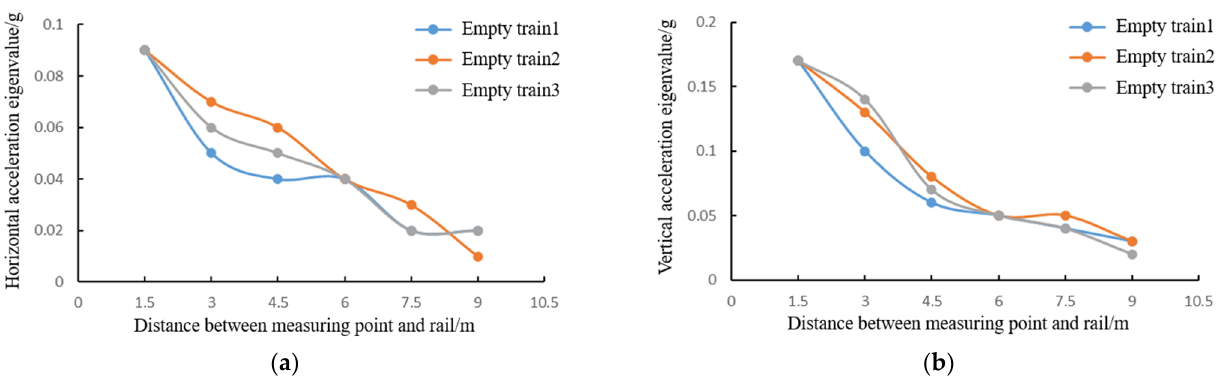
Figure 10. Acceleration change curve of each measuring point of the no-load train. ( a ) Horizontal acceleration change curve of each measuring point of the no-load train; ( b ) vertical acceleration change curve of each measuring point of the no-load train.